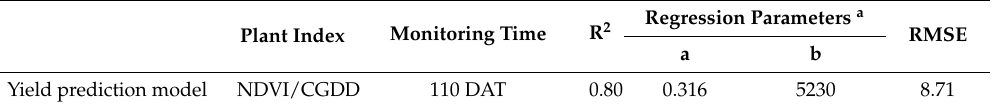
a Regression parameter, in − season yield = a × e b × index value . The integrated yield prediction model was built from the data obtained with JB cultivar in year I and II and PB cultivar in year II.